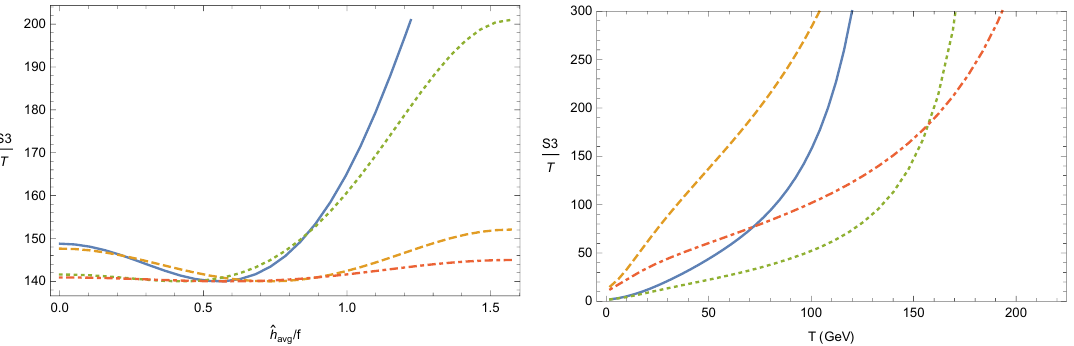
Figure 8 . The action S 3 =T of O (3)-symmetric bubbles for a meson-like dilaton with m (cid:31) = 600 GeV, N = 4 (blue solid) and m (cid:31) = 1000 GeV, N = 4 (green dotted) and a glueball-like dilaton with m (cid:31) = 600 GeV, N = 4 (orange dashed) and m (cid:31) = 1000 GeV, N = 4 (red dot-dashed). Left: at the nucleation temperature and as a function of ^ h avg parametrizing the tunnelling path. Right: at the minimum with respect to ^ h avg and as a function of the temperature. The point of intersection with the critical action S 3 =T = 140 gives the nucleation